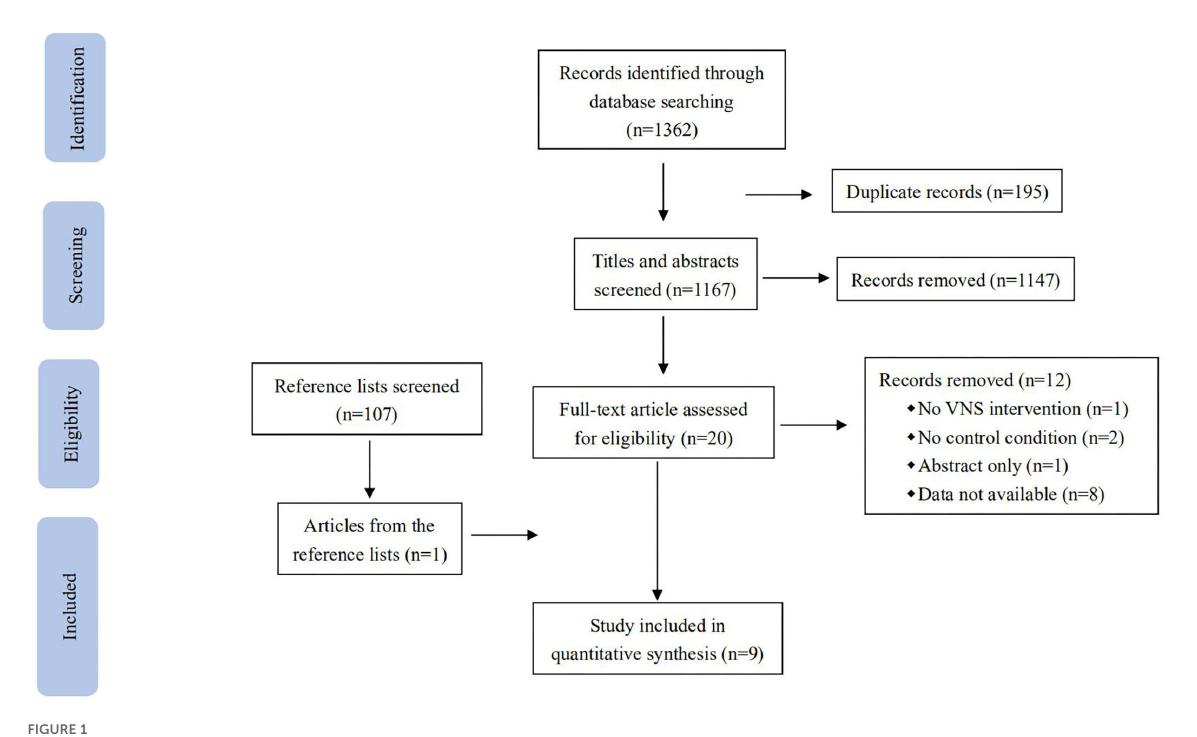
FIGURE1 Flow chart for search and study